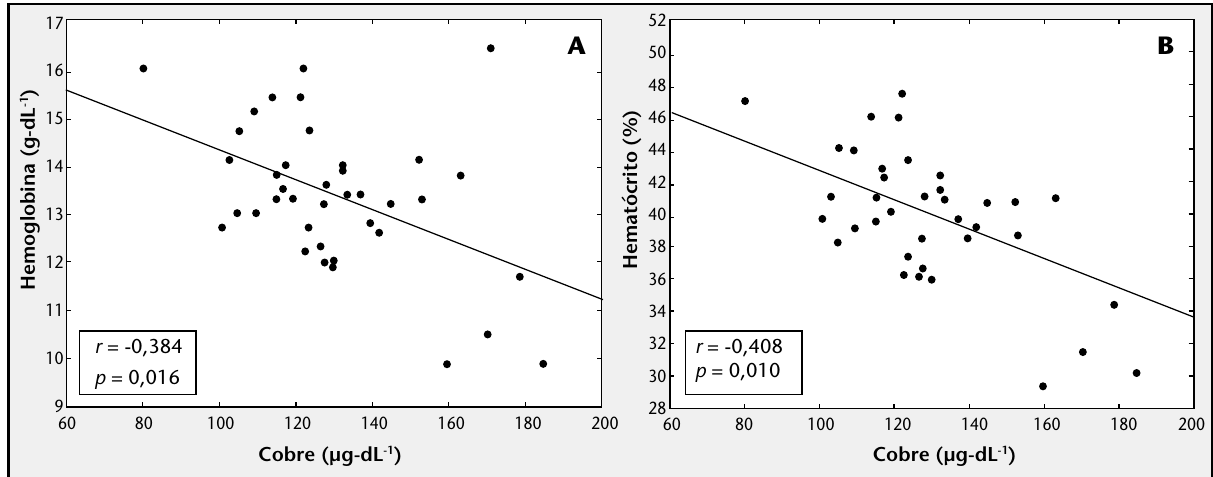
Figura 1 – Correlação entre níveis séricos de cobre versus concentrações de hemoglobina (a) e valores de hematócrito (b) no grupo das mulheres idosas ( n =